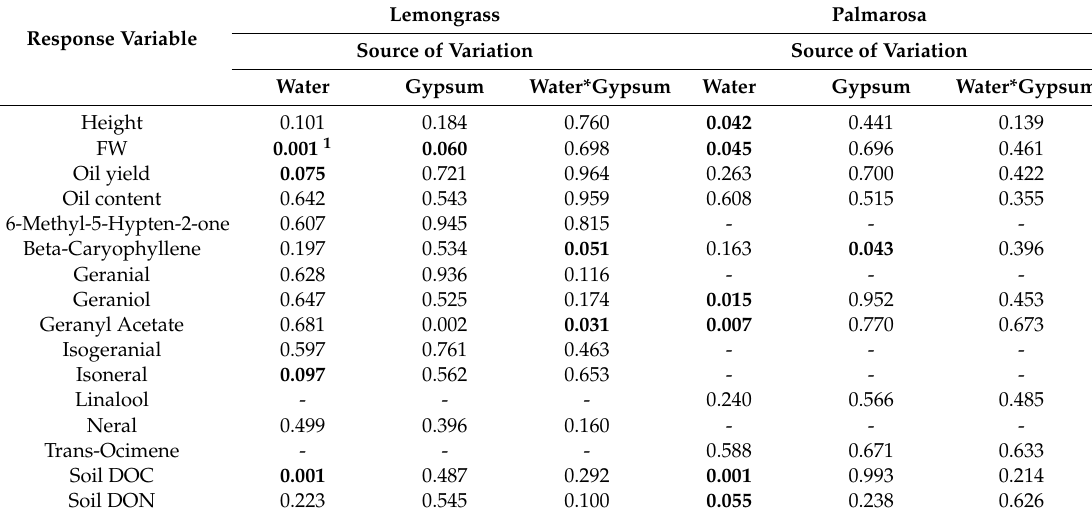
Table 2. ANOVA p-values for the main and interaction e ff ects of Water and Gypsum on lemongrass and palmarosa Height (in), Fresh weight (FW, g), Oil yield (g), and Oil content (%); oil composition [6-Methyl-5-Hepten-2-one (%), Beta-Caryophyllene (%), Geranial (%), Geraniol (%), Geranyl Acetate (%), Isogeranial (%), Isoneral (%), Linalool (%), Neral (%), and Trans-Ocimene (%)]; and soil DOC ( µ g / g OD soil) and DON ( µ g / g OD